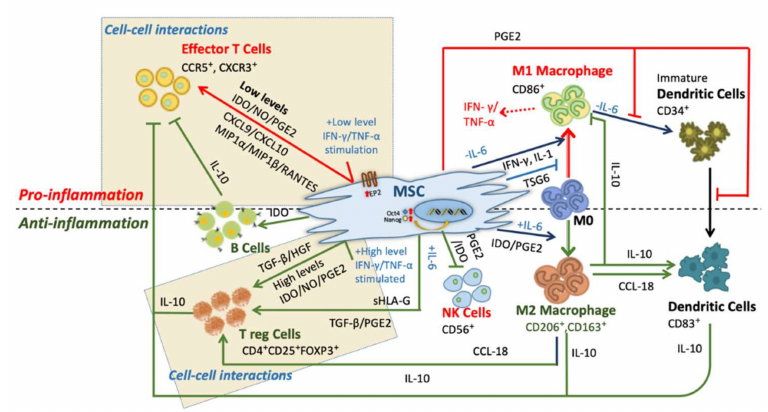
Figure 1. The central role of Mesenchymal Stem Cells (MSC) in immune responses. The above figure distinguishes the response and interaction of MSCs in pro-inflammatory and anti-inflammatory conditionsonimmunecells. Thesee ff ectsdemonstratecell-to-cellcontact-mediatedimmunosuppression of B and T cell proliferation, induction and transforming growth factor- β (TGF- β ) / hepatocyte growth factor(HGF)mediatedregulationofregulatoryTcells. Also, itshowsthecapacityofimmunomodulation of MSCs by inhibiting the natural killer (NK) cells, dendritic cells (DCs) at various maturation stages as well as macrophage polarization dependency on the